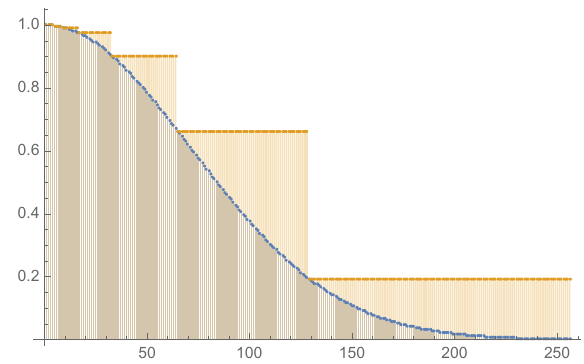
FIG. 5. Illustration of state-generation steps before perform- ing an inequality test. First we prepare a state with amplitudes according to the orange points. Then we test an inequality against the blue points. The success probability is at least about